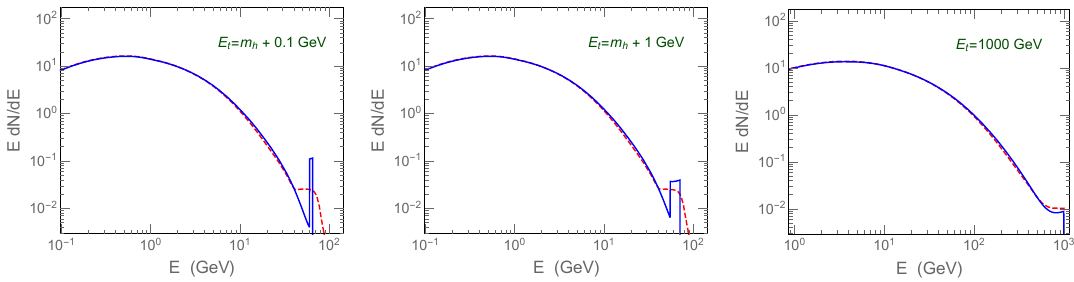
Figure 3 . Gamma-ray spectra for DM DM ! SS with m S = m h . Here E t (= m DM ), is the total energy of a (cid:12)nal state S . The solid blue curve is our result, in comparison with the case of DM DM ! hh (dashed red curve) obtained directly from the PPPC4DMID package [52, 53], which was generated from Pythia 8.135